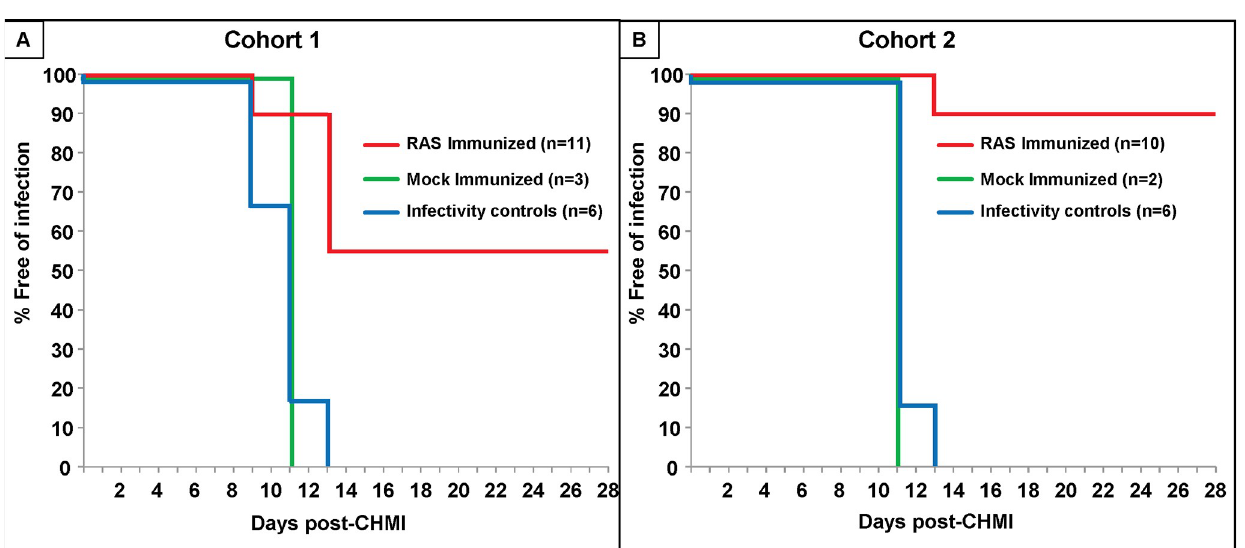
only two mock-immunized subjects, we combined both controls. The combined mock-immu- nized and infectivity controls became parasitemic between 9–13 days after CHMI (9, 9, 11, 11, 11 11,11, 13 days, mean 10.75 days; SD = 1.28 days; mean+2SD = 13.31 days). Therefore, the